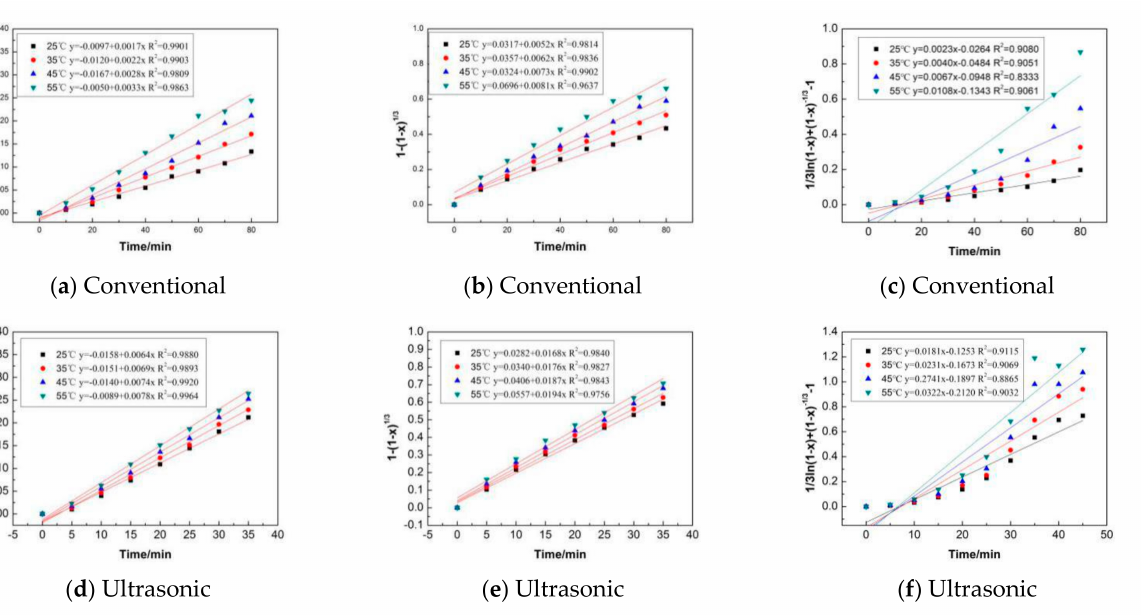
Figure 9. Fitting of control steps at different